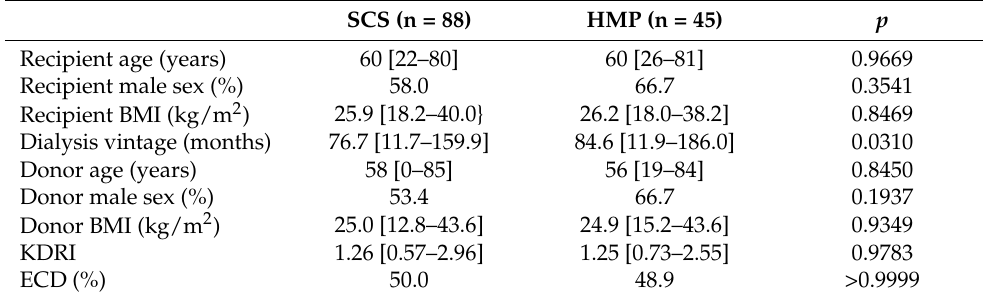
Table 1. Patients’ demographics, donor and organ allocation